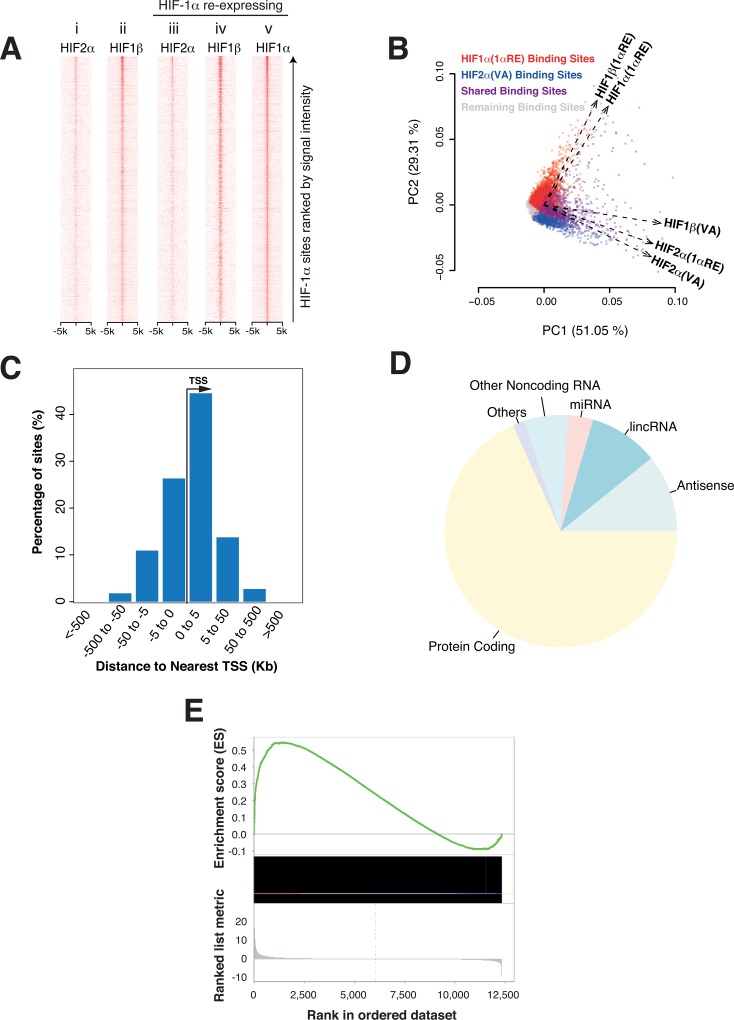
HIF-1α re-expression in 786-O cells.(A) HIF-1α binding sites in the HIF-1α re-expressing cells were identified by peak calling and ranked on the vertical axis according to signal intensity. Heat maps of these sites (±5kb on horizontal axis) showing ChIP-seq read density for the indicated HIF subunits were generated for both the control cells (i, ii) and the HIF-1α re-expressing cells with HIF-1α re-introduced (iii-v). The pattern of HIF-2α binding is minimally affected by the re-expression of full-length HIF-1α (compare i and iii). Sites binding re-expressed HIF-1α are largely co-occupied by HIF-1β (compare iv and v). (B) Biplot showing Principal Component Analysis (PCA) of ChIP-seq signal intensity (RPKM values) for both individual binding sites (dots) and HIF-subunits (vectors) across all HIF-binding sites identified in control cells and in HIF-1α re-expressing cells. Sites binding endogenous HIF-2α in control cells are shown in blue while sites binding re-expressed HIF-1α are shown in red, sites binding both are colored purple and the remaining sites are shown in grey. PCA for each subunit shows high co-variance between HIF-2α binding in the control cells and in the HIF-1α re-expressing cells (compare HIF2α(VA) and (HIF2α(1αRE)). This indicates only minimal change in the HIF-2α binding as a consequence of the HIF-1α re-expression. Conversely, the HIF-1β vector changes dramatically with HIF-1α re-expression (compare HIF1β(VA) with HIF1β(1αRE)) and aligns closely with the vector for re-expressed HIF-1α (HIF1α(1αRE)). The individual binding sites in the control and HIF-1α re-expressing cells (blue and red dots) aligned closely with their respective PCA vectors. (C) Histogram of the distance to nearest transcription start site (TSS) for HIF-1α binding sites in cells re-expressing HIF-1α. (D) HIF-1α binding sites in the re-expressing cells were categorized according to the class (Ensemble) of the nearest gene. The relative frequency of each class is show by pie chart. (E) Gene set enrichment analysis (GSEA) for the set of genes nearest to HIF-1α binding sites when genes are ranked according to fold-change and significance in mRNA expression following re-expression of HIF-1α (horizontal axis).